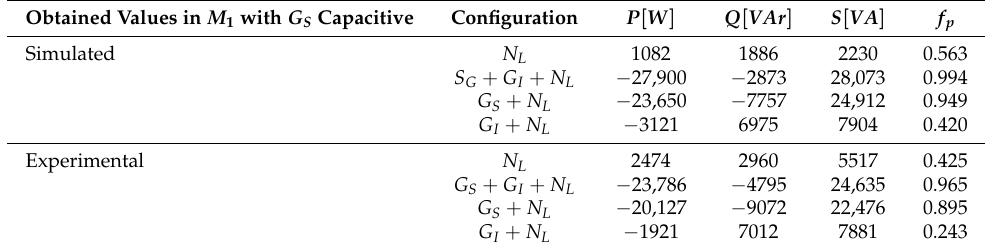
Table 10. Obtained values in M 1 with G S